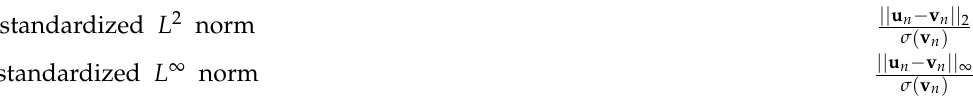
Table 2. Adopted error measures, where σ ( v n ) is the standard deviation of the TS v n . standardized L 2